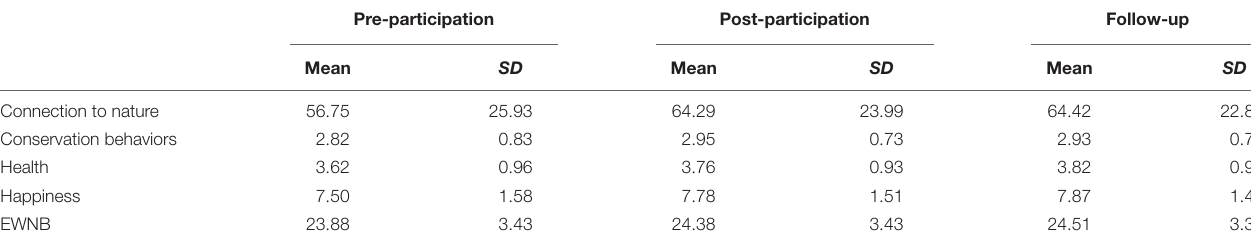
TABLE 3 | Pre, post-participation and follow-up mean and standard deviations for the four outcome